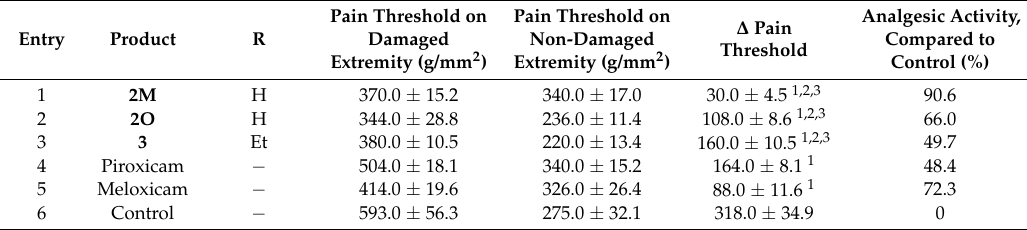
Table 3. The Analgesic Activity of Esters 2M , 2O , 3 , and Reference Drugs.